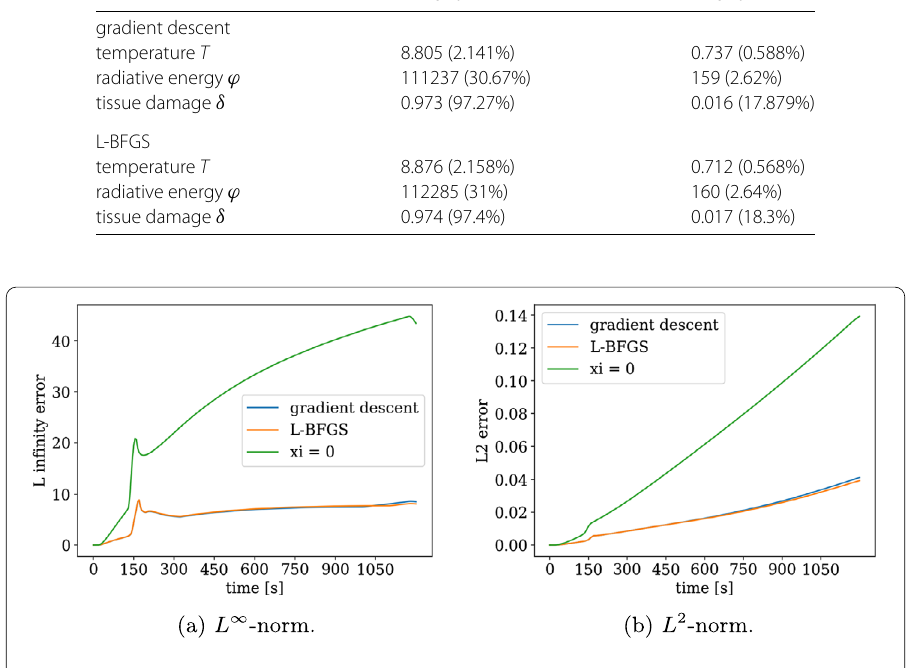
Figure 9 Evolution of the error in temperature over time for one noisy measurement